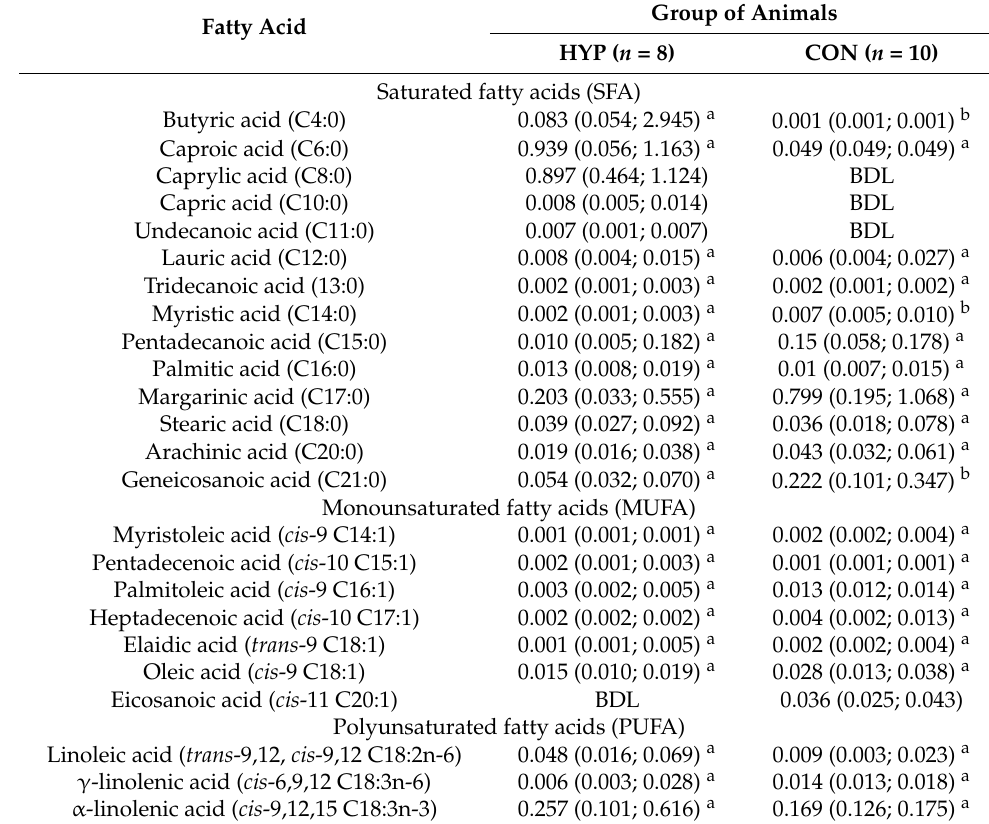
Table 2. Spectrum of free fatty acids ( µ g/ µ L) in blood serum of dairy cows under conditions of hyperthermia (HYP) or in the control group (CON), presented as median (25th and 75th percentile values in